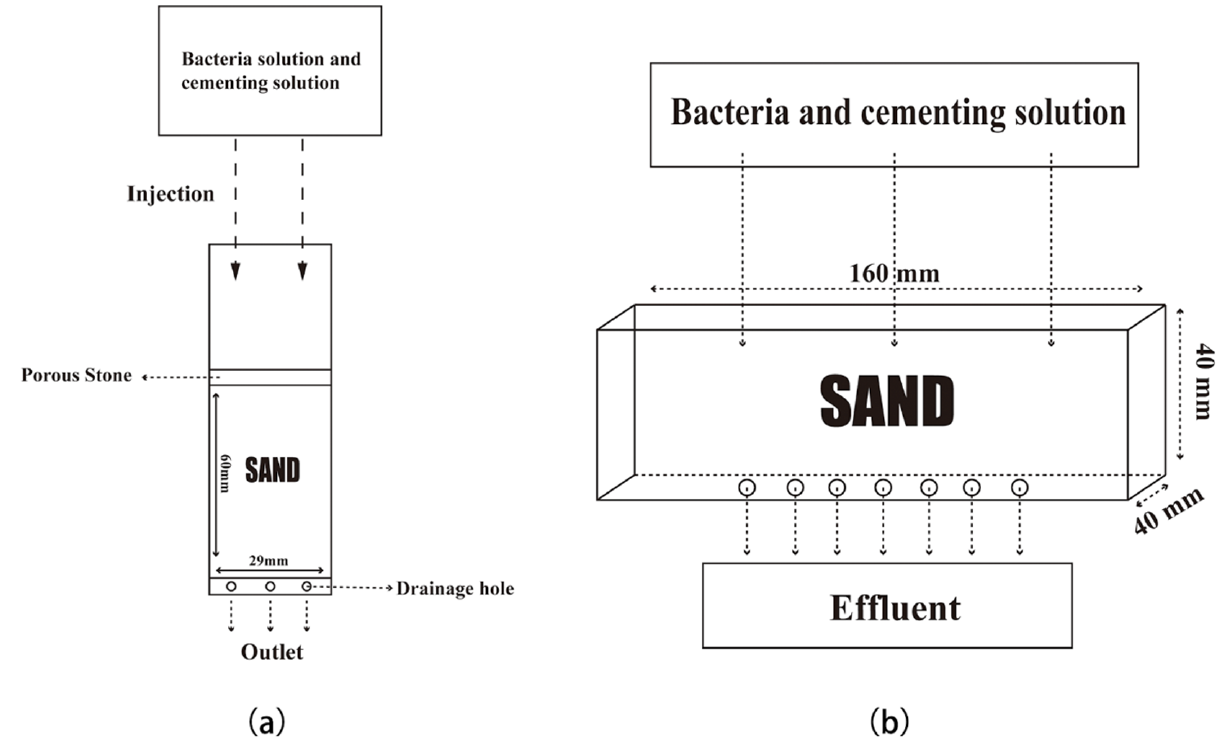
Figure 2. Two molds used in this research: ( a ) 29 × 60 mm size mold; ( b ) 40 × 40 × 160 mm size